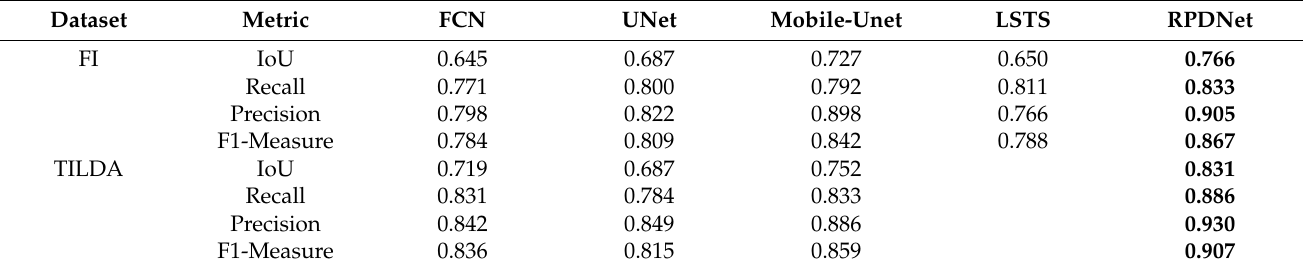
Table 3. Quantitative comparison of different detection